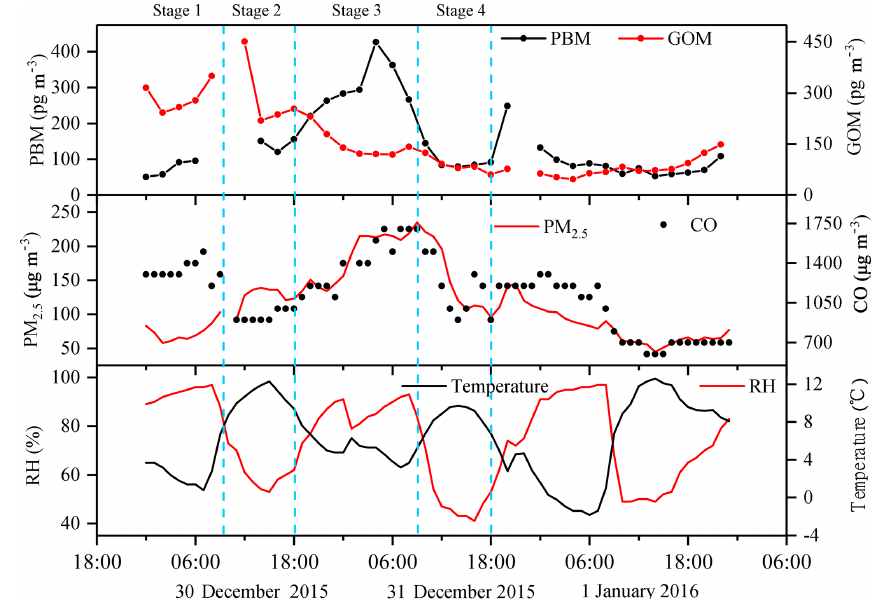
Figure 14. A case study of gas–particle portioning between GOM and PBM from 30 December 2015 to 1 January 2016, which was divided into different stages. The time series of PBM, GOM, PM 2 . 5 , CO, temperature, and RH are